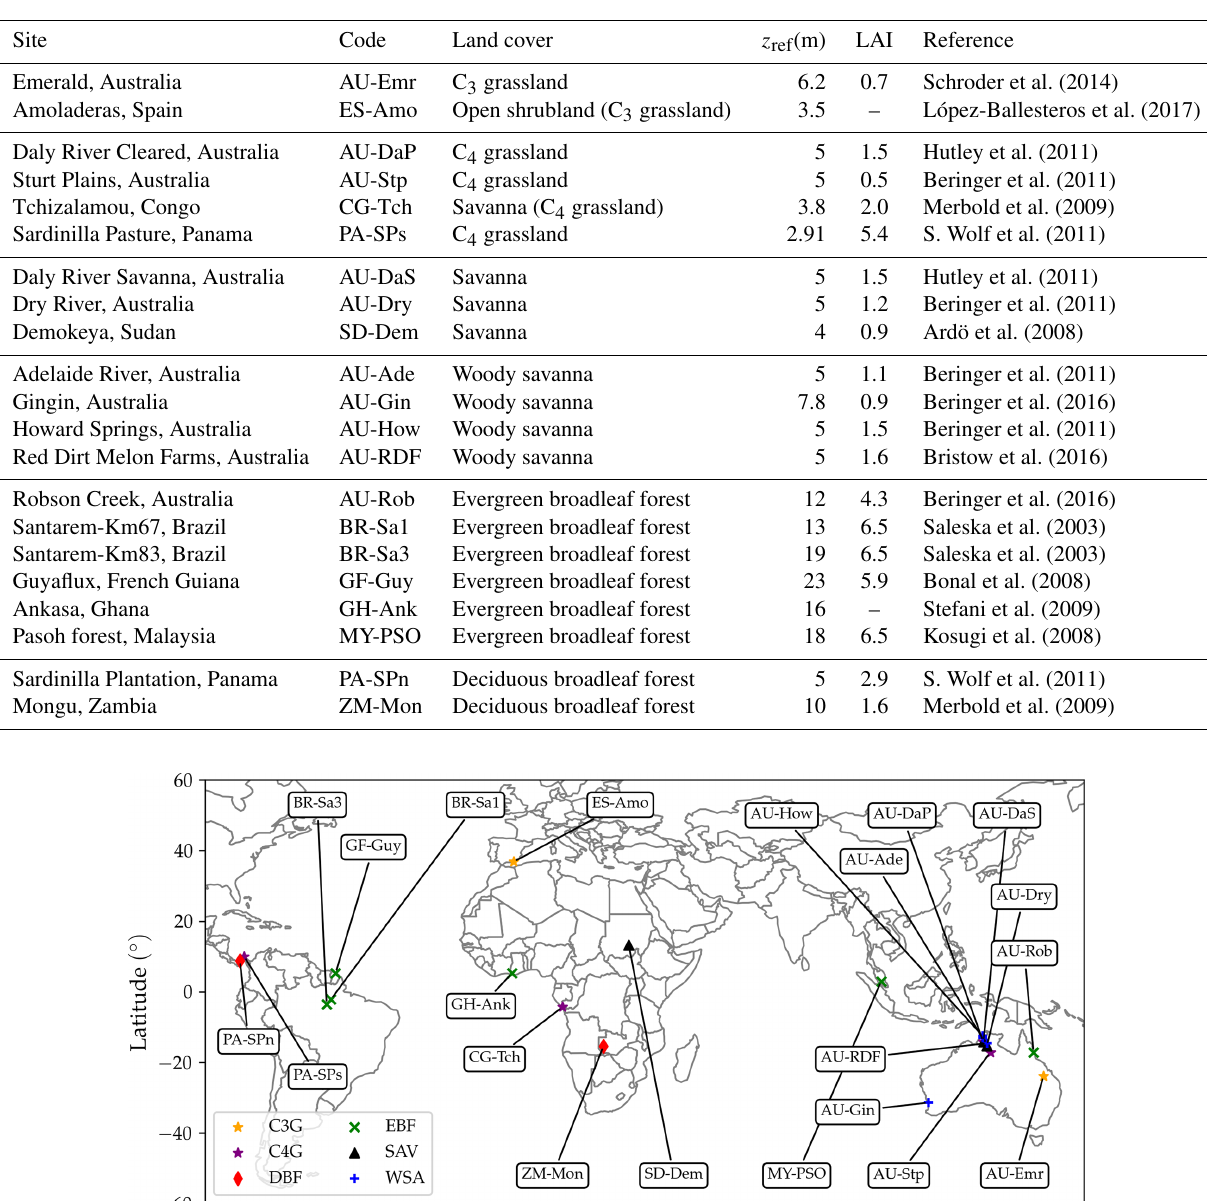
Table 2. Brief description of selected sites. The land cover classification was taken from the FLUXNET site description web pages. The reference level height is taken as the height of the measuring sensors above the canopy. A dash indicates that we were not able to find an observed LAI value for the site.